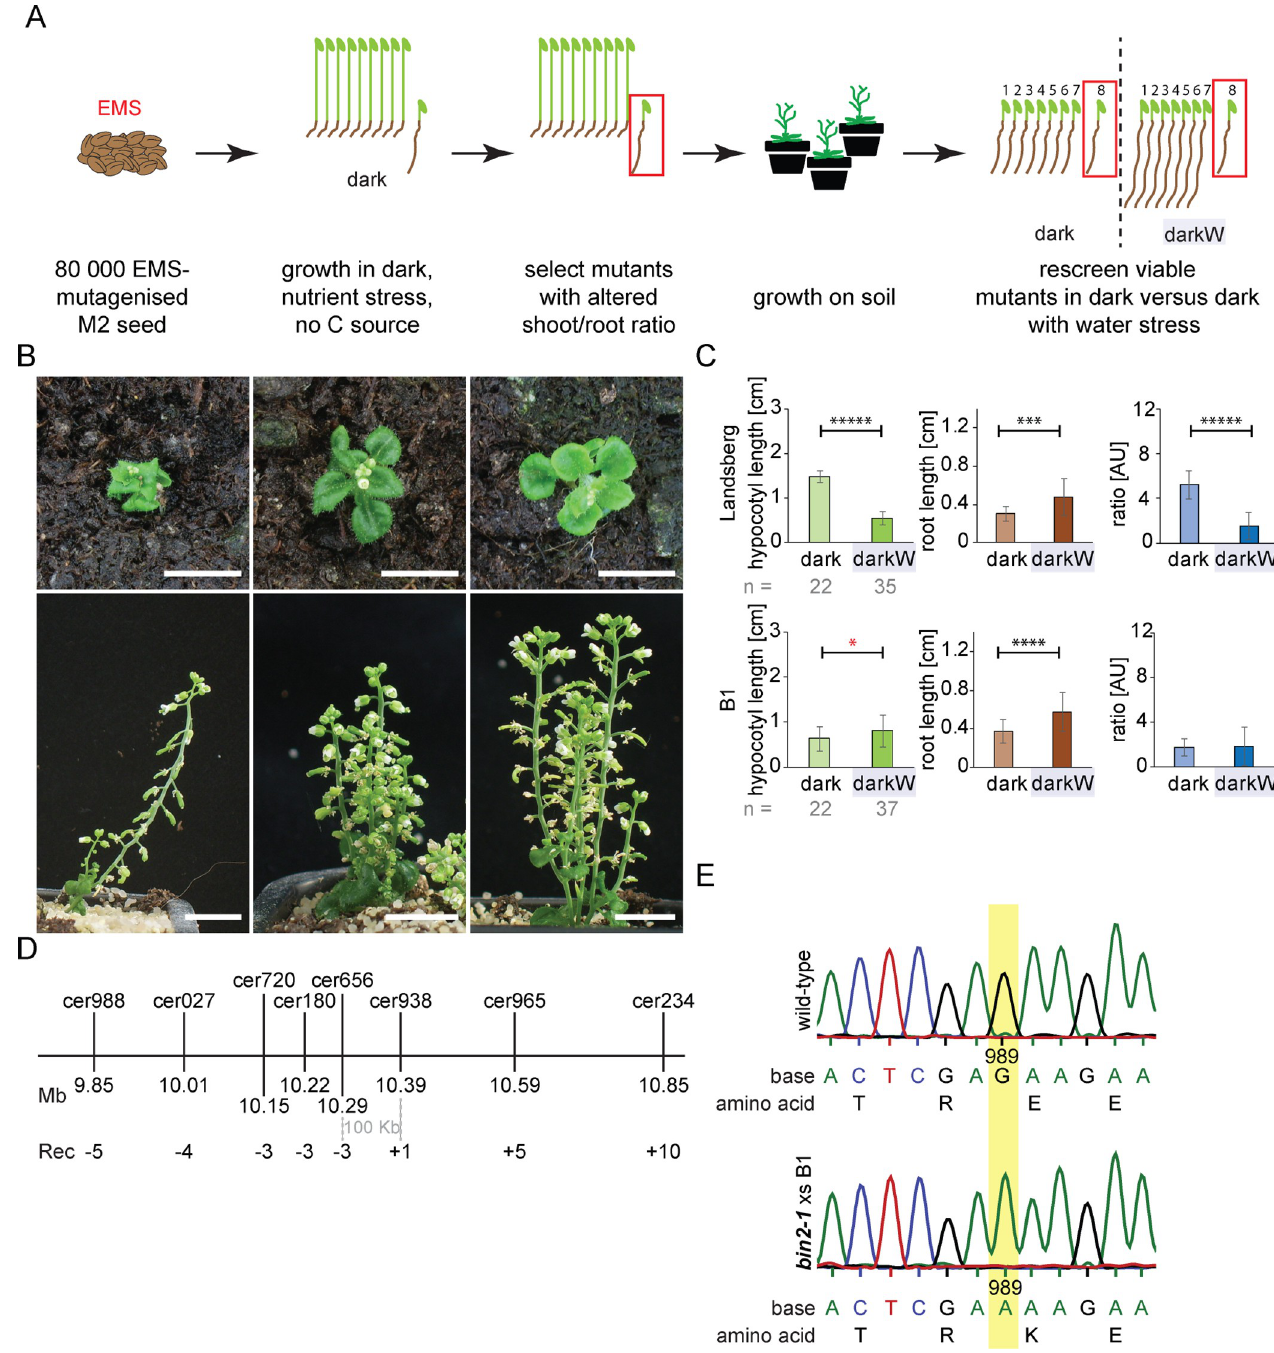
Fig 2. Identification of BIN2 and its role in hypocotyl/root tradeoffs. (A) A screen for decision mutants; two consecutive steps are depicted (see text). (B) Dwarf mutants with curled-in leaves, a BR-related phenotype, identified in our forward genetic screen on the basis of altered hypocotyl/root ratios in the dark. Scale bars = 1cm. (C) B1 mutants fail to adjust their hypocotyl/root ratios in response to water stress in the dark (darkW). Note that hypocotyls had an inverse response (significance marked with red asterisk). The number (n) of seedlings measured per condition is in grey below mean ± StDev bar graphs. P -values were computed with a two-tailed student’s T -test and are represented as follows: � : 0.05–0.01; ��� : 0.001–0.0001; ���� : 0.0001–0.00001, ����� : < 0.00001. (D) Fine mapping of mutant B1 identifies a 100 kb interval on chromosome 4, which spans the BIN2 locus. Markers used for mapping are depicted in abbreviated form above the line and in full detail in S6 Method . Rec: recombinants. See S6 Method for mapping and S2 Table for segregation analyses. (E) Sequencing of the BIN2 TREE domain in F1 segregants of a complementation cross between bin2-1 and B1 shows that B1 harbors a G to A transition at position 989 (yellow highlight), giving rise to an E263K mutation identical to that of bin2-1 . n = 10 F1 plants were sequenced. See related S6 Fig .